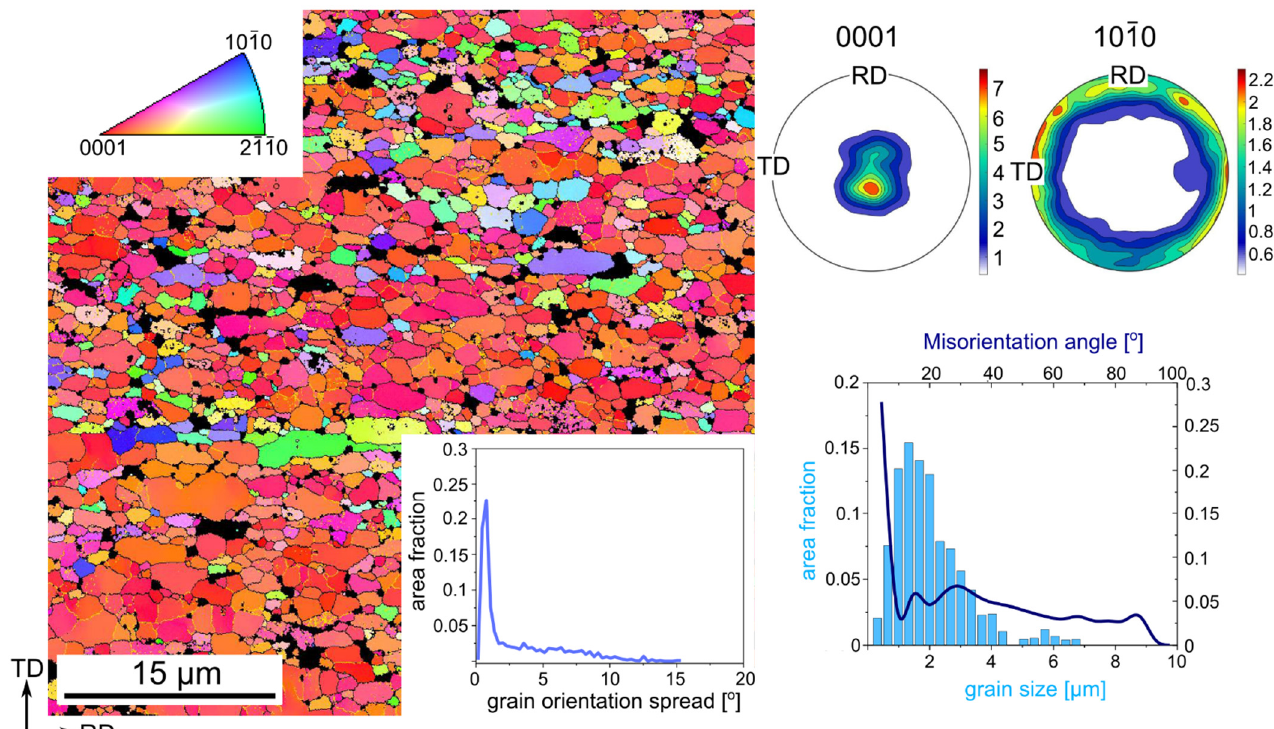
Figure 12. Orientation map with the GOS chart, (0001) and (1010) pole figures and distribution of grain size and misorientation angle of the cold-rolled Zn-1Cu alloy with the reduction rate of 90% acquired from the necking of the sample after tensile test. Dark areas related to the CuZn 4 phase were excluded from the analysis. HAGBs and LAGBs were marked with black and yellow colors, respectively. The orientation map is color-coded based on the IPF triangle depicted in the right upper corner with respect to the ND.